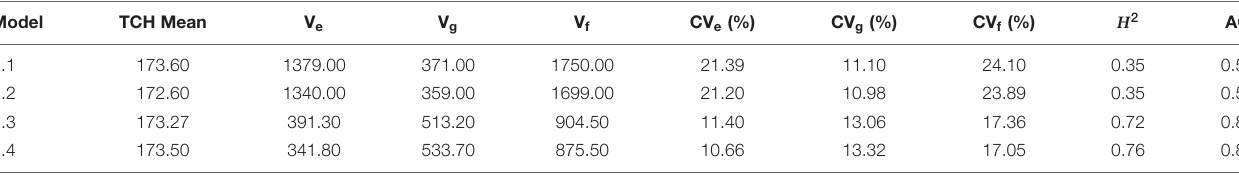
TABLE 3 | Estimates of the variance components (REML) considering the different statistical models, Experimental Area 2.